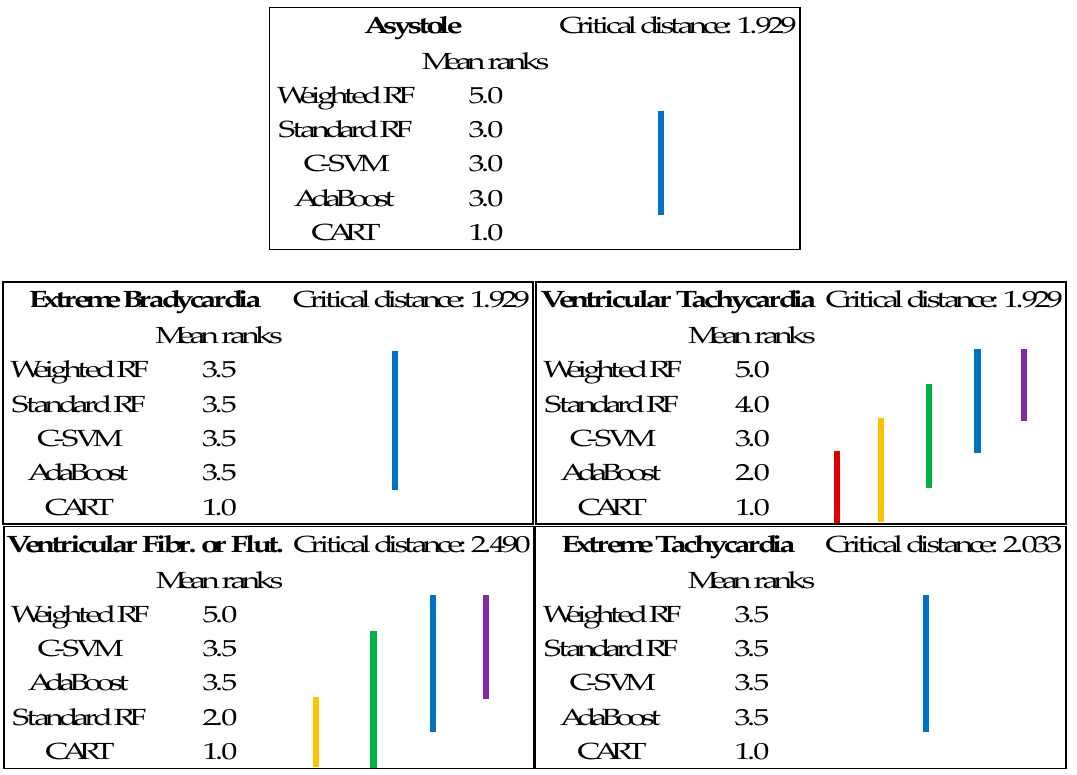
Figure 2. Nemenyi diagram for benchmarking methods for Score measure.